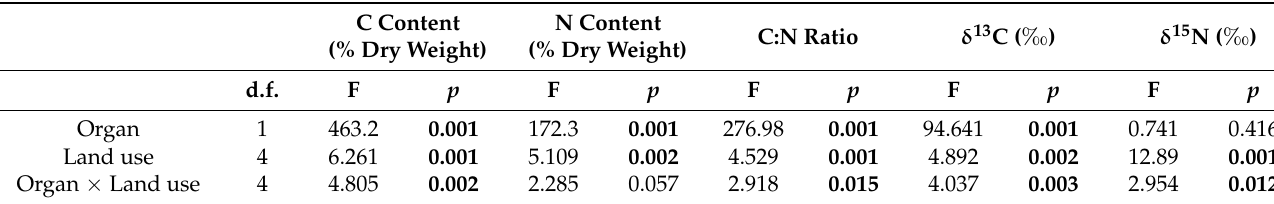
Figure 3. Spatial distribution for the elemental composition for buffelgrass in Sonora, Mexico. Carbon content (C%, dry weight) for ( A ) leaves and ( B ) seeds, nitrogen content (N%, dry weight) for ( C ) leaves and ( D ) seeds, and the C:N ratio for ( E ) leaves and ( F ) fascicles. Image data: Google Earth; date: 20 April 2020. Table 3. Two-way PERMANOVA for carbon and nitrogen parameters of buffelgrass growing in Sonora, Mexico. p -values in bold indicate significant differences.